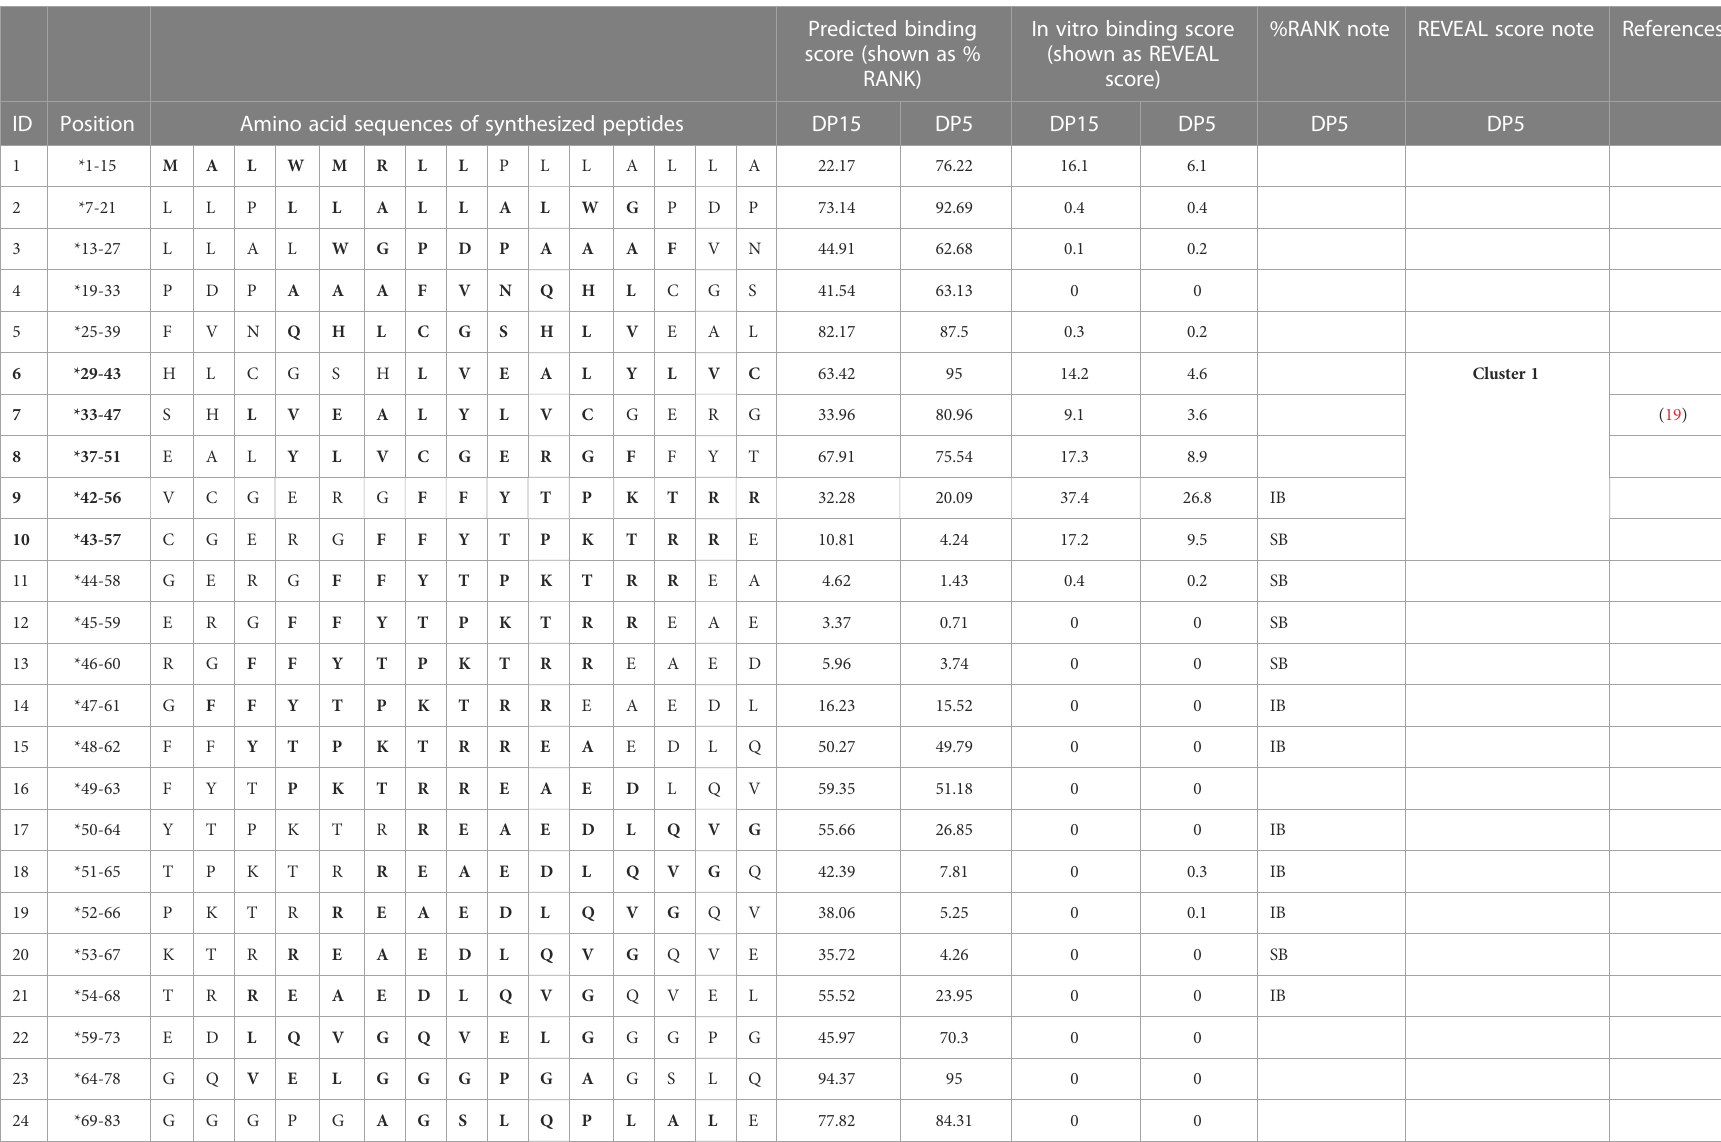
TABLE 4 Human proinsulin-derived peptides and their af fi nities to HLA-DP5 and HLA-DP15 in silico and in vitro .